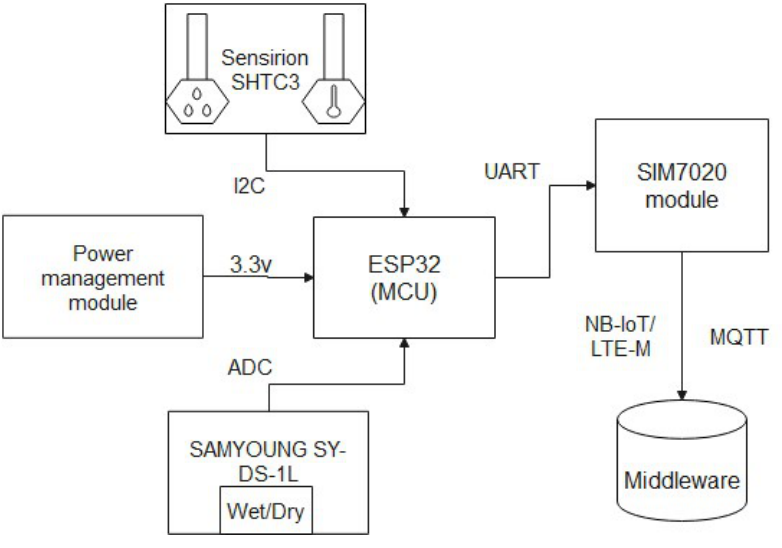
Figure 1. System Architecture.